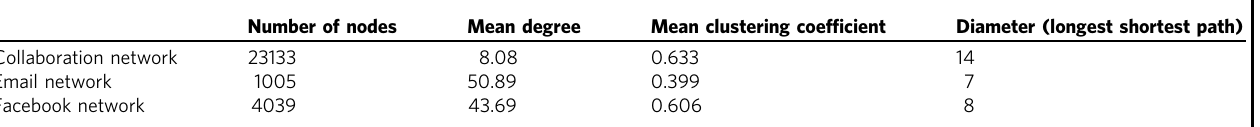
Table 1 Basic properties of real-life